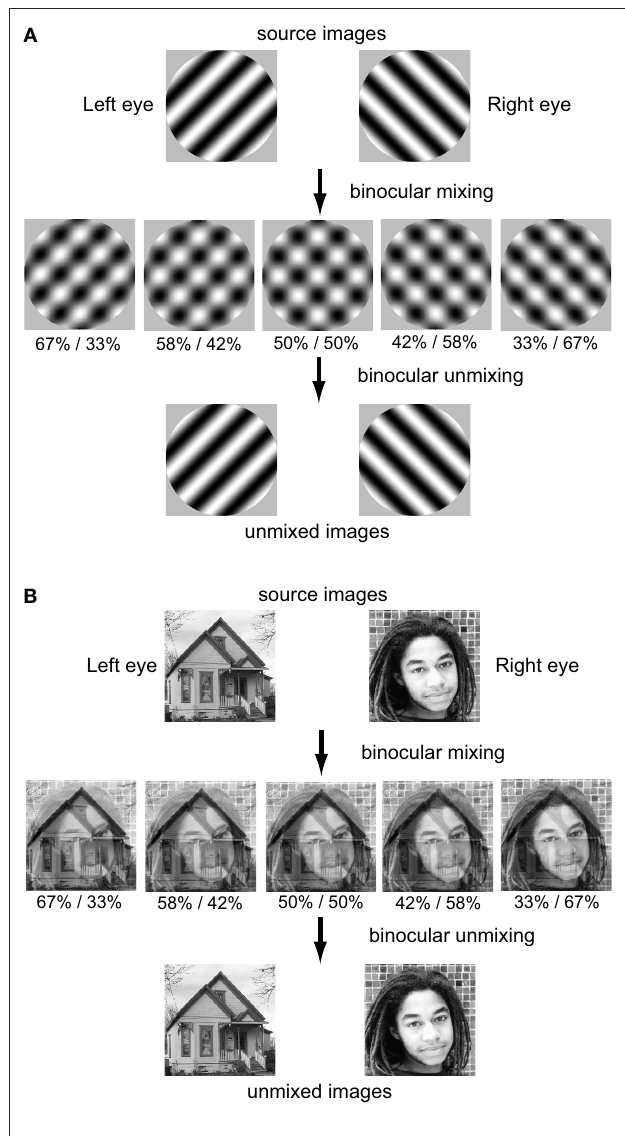
Figure 1 | Schematic of image mixing and unmixing